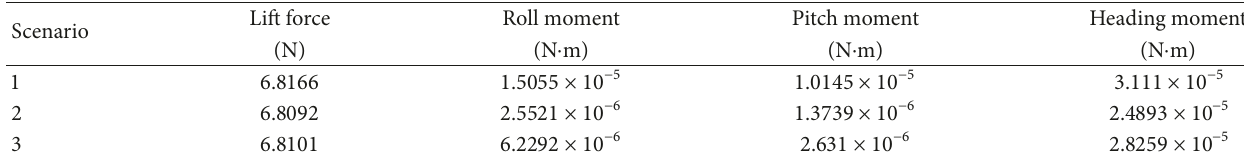
Table 9: Comparison results of induced efforts.